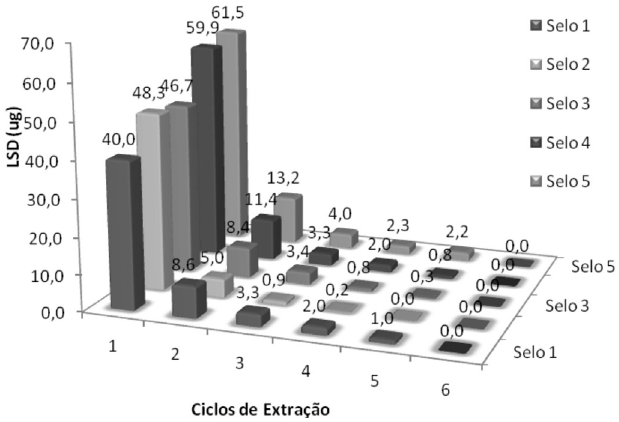
FIGURE 3 - Amount of LSD extracted from five LSD blotter papers in each cycle.